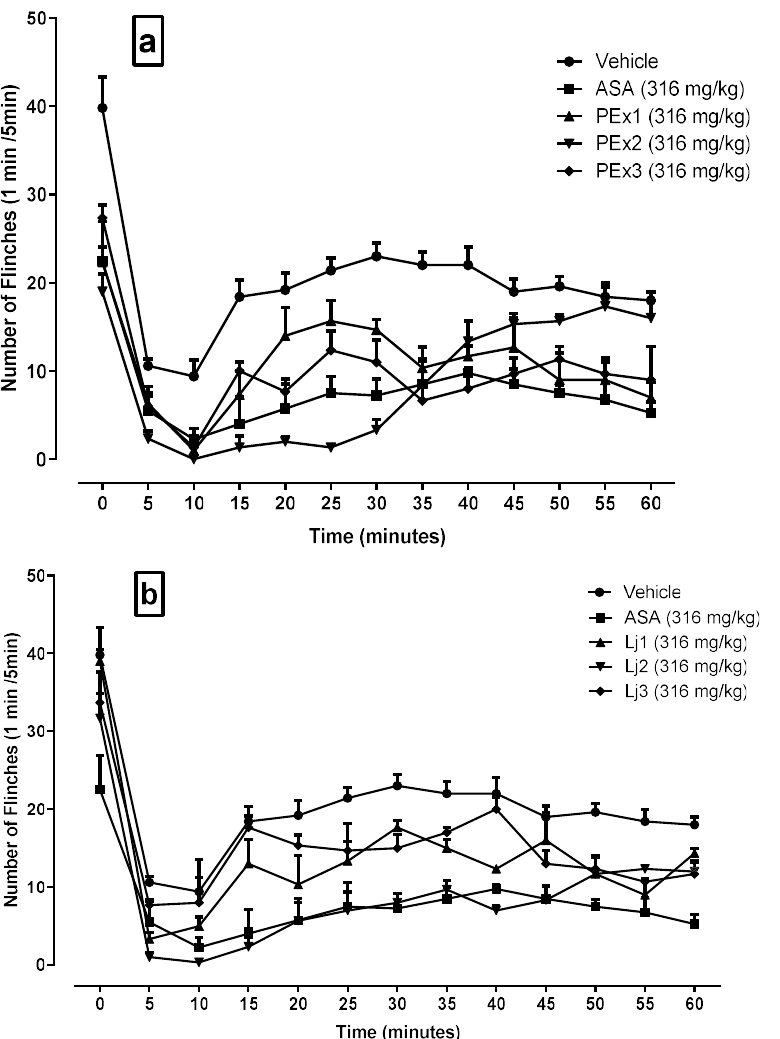
Figure 1. Time courses of the formalin test obtained by the intragastric administration of the extracts of peel and lyophilized juice of the three varieties of pomegranate. ( a , b ) shows the flinches by time intervals (1 min every 5 min, up to 60 min).